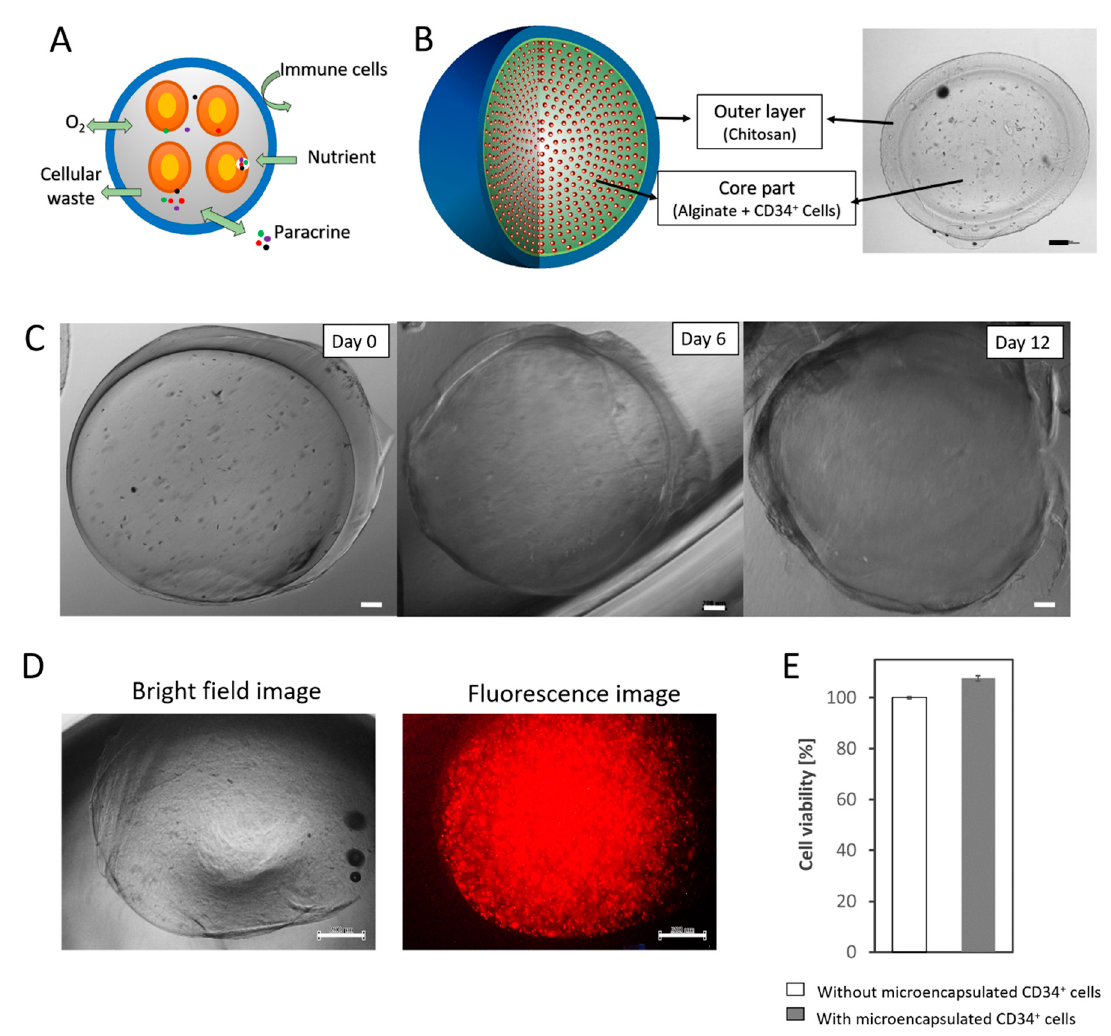
Figure 1. ( A ) Illustration of microencapsulation with a semi-permeable barrier. ( B ) Schematic and microscopic image of double-layered alginate-chitosan microcapsule. ( C ) Stability of alginate-chitosan microcapsules in culture media. ( D ) Microscopic images of cell-loaded microcapsule after DNA staining. Scale bars in ( B – D ) represent 100 and 200 µ m, respectively. ( E ) Cytotoxicity of alginate-chitosan microcapsules for external CD34 + cells.